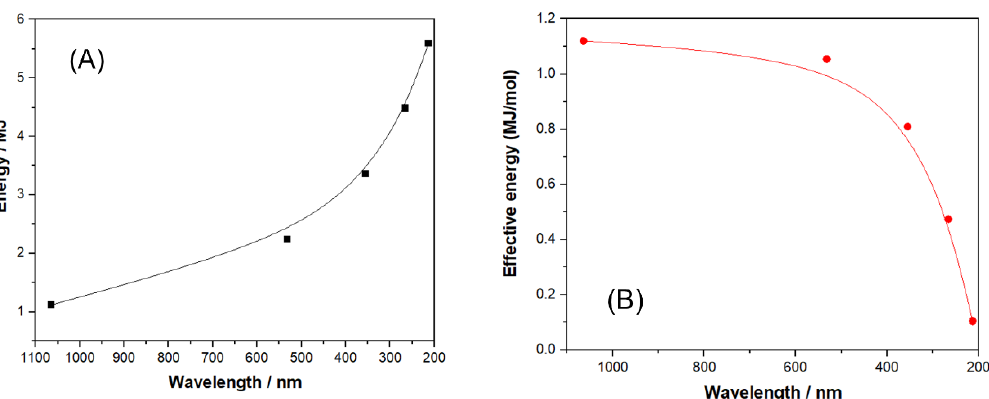
Figure 5. Energy of the laser (Equation (2)) ( A ) and effective energy after frequency doubling ( B ).